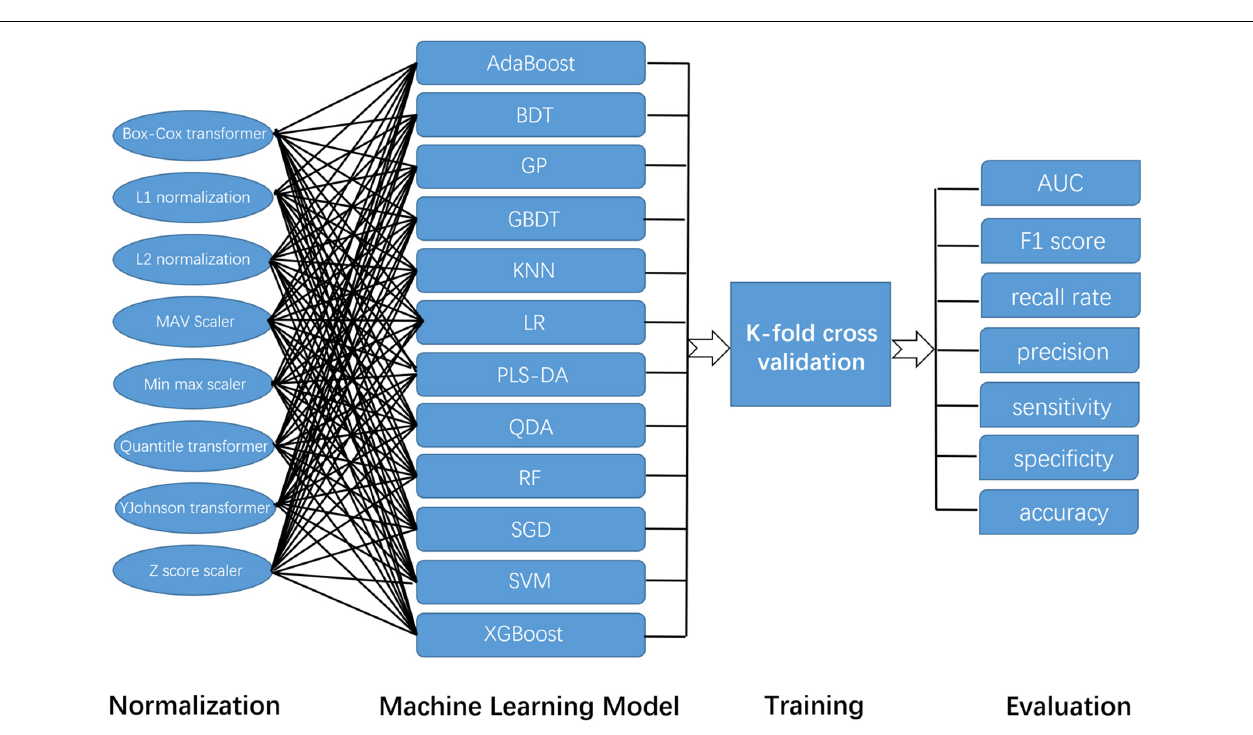
System (Siemens, Germany) with a 20-channel head coil. Sagittal T1-weighted structural images were acquired for each subject using a magnetization-prepared rapid gradient echo (MPRAGE)